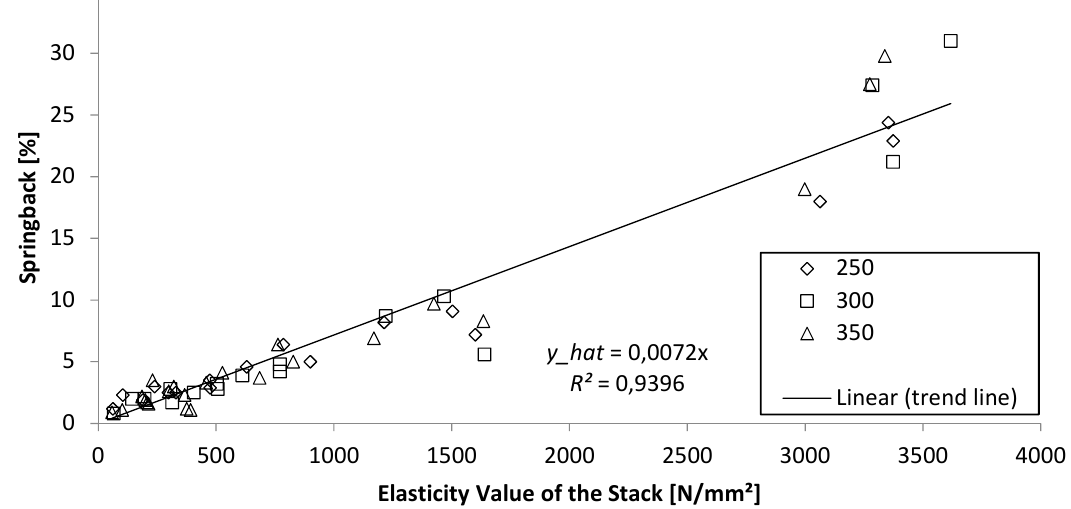
Figure 3. Linear correlation of springback and elasticity value. The different radii are separately marked.